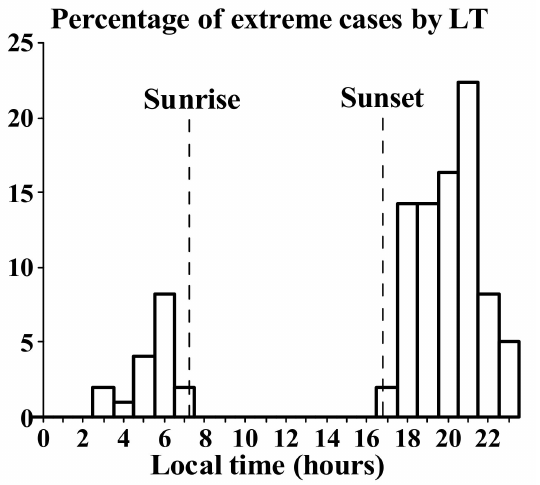
Figure 2. Local time distribution of extreme ionospheric disturbances from the Irkutsk database (2003–2016) of ∆ NmF2 with 15 min